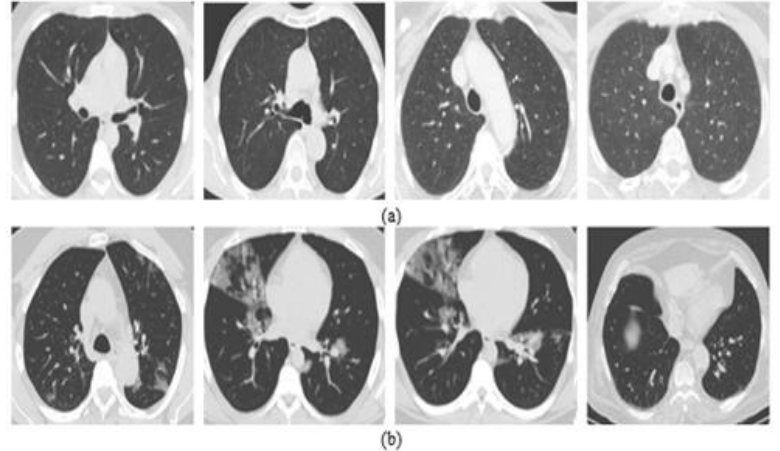
Figure 3. Samples of patients from the CT dataset: ( a ) non-COVID-19 and ( b ) COVID-19.